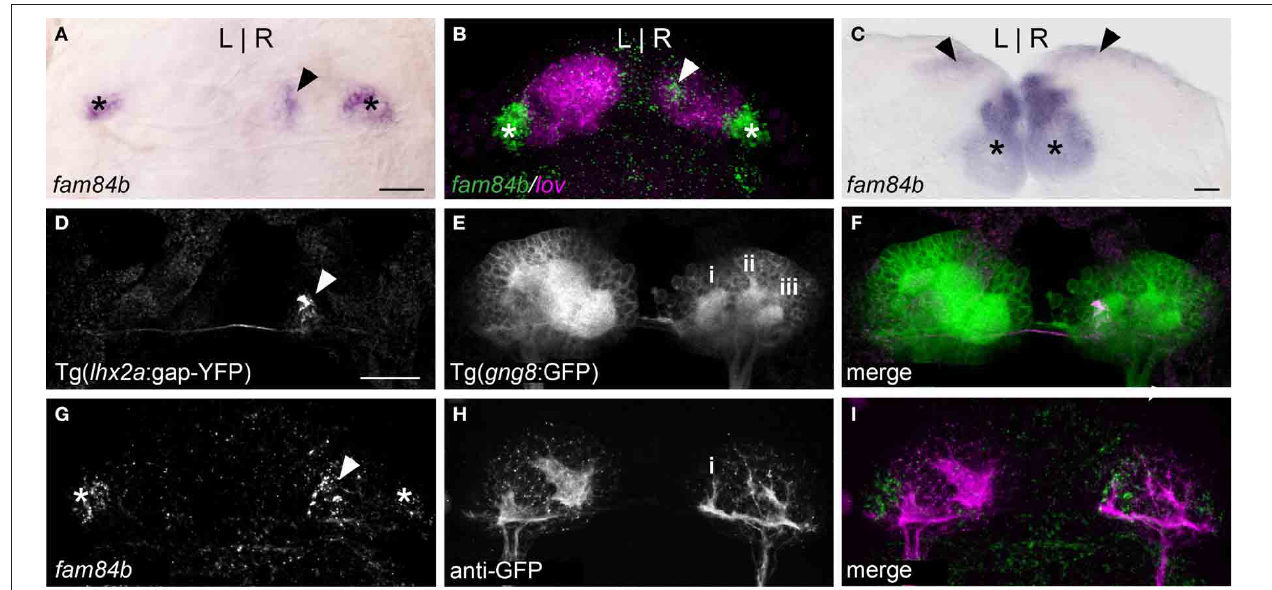
Tg ( gng8 : nfsB-CAAX-GFP ) c375 larva reveals that axons of lhx2a:YFP labeled olfactory mitral cells (white arrowhead in D ) terminate at the medial neuropil (i in E ) of the right habenula. More lateral neuropil clusters are indicated (ii,iii). (G–I) Themedialneuropil cluster (i)visualizedbyanti-GFP immunofluorescence in Tg ( gng8 : nfsB-CAAX-GFP ) c375 larva is closely associated with the fam84b expression domain (white arrowhead in G ) revealed by fluorescent in situ hybridization. All larvae 4 dpf; scale bars = 50 μ